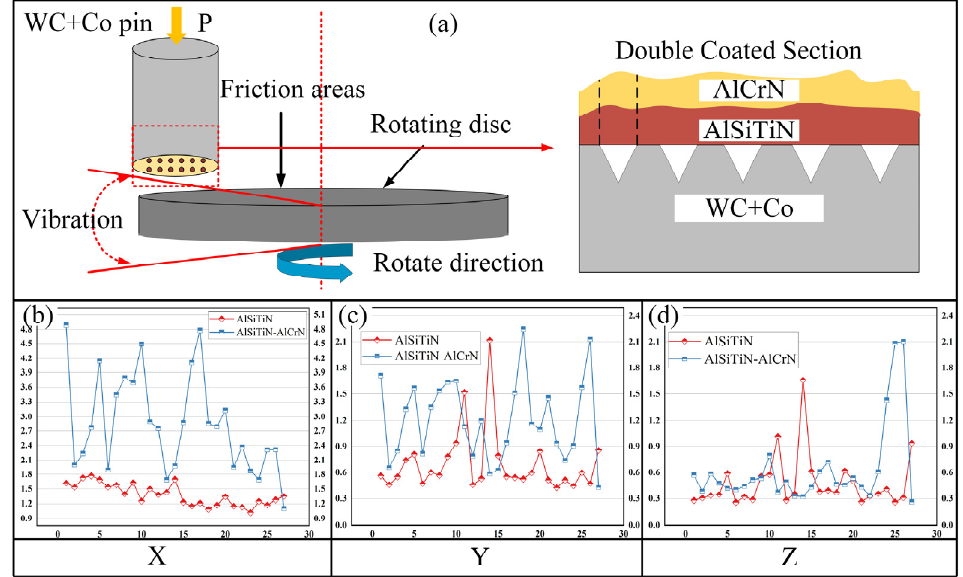
Figure 10. Vibration test results. ( a ) Vibration experiment operation diagram. ( b ) Vibration experi- mental data in X direction. ( c ) Vibration experimental data in Y direction. ( d ) Vibration experimental data in Z direction.